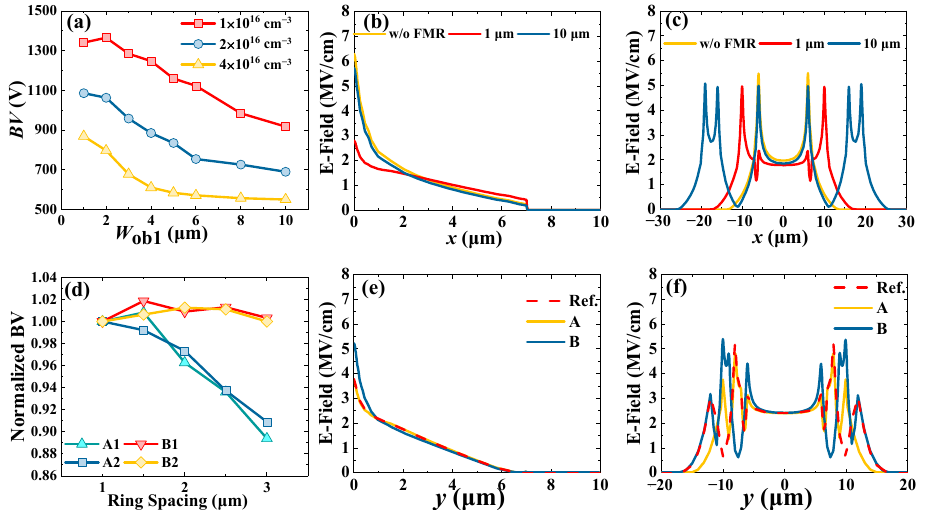
Figure 5. Relationship between breakdown voltage and FMR spacing. ( a – c ) Single FMR, ( a ) break- down voltage decreases as FMR spacing increases; ( b , c ) electric field distribution at the breakdown, ( b ) vertical profile, and ( c ) lateral profile. ( d , f ) Double FMRs; ( d ) inner spacing has a greater effect on breakdown voltage than outer spacing; ( e , f ) electric field distribution at 810 V; ( e ) vertical profile; and ( f ) lateral profile.